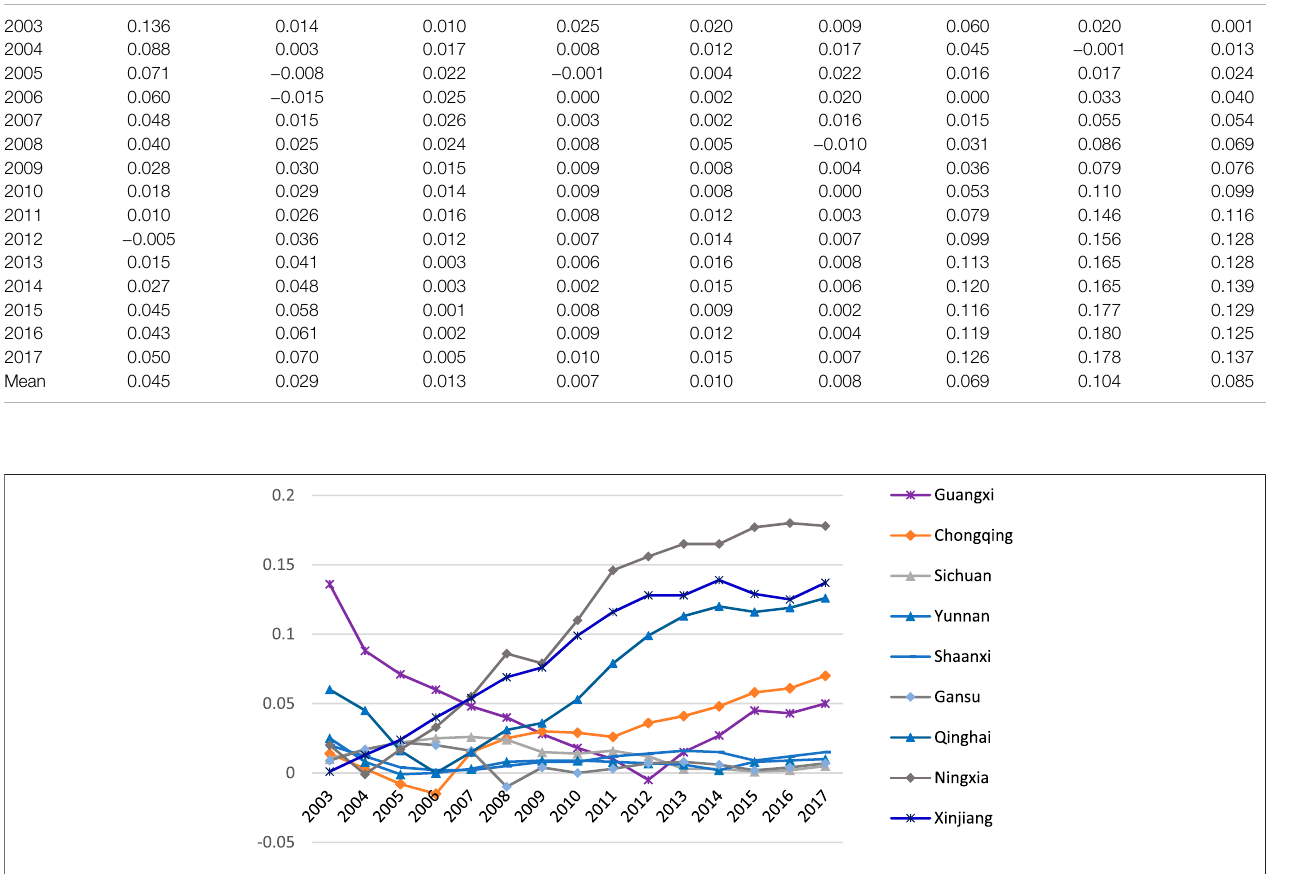
FIGURE 1 | Trend Chart of the improvement effect of regional human